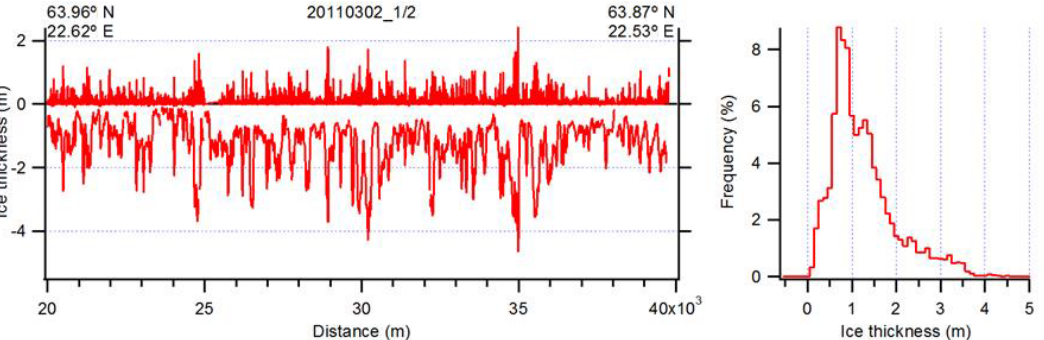
Figure 2. A 20km section of combined surface laser profile and EM thickness profile, and the corresponding ice thickness histogram for the 2011 field campaign data. The laser profile resolves all ridge sails, while the EM profile averages thickness over an altitude-dependent footprint, typically